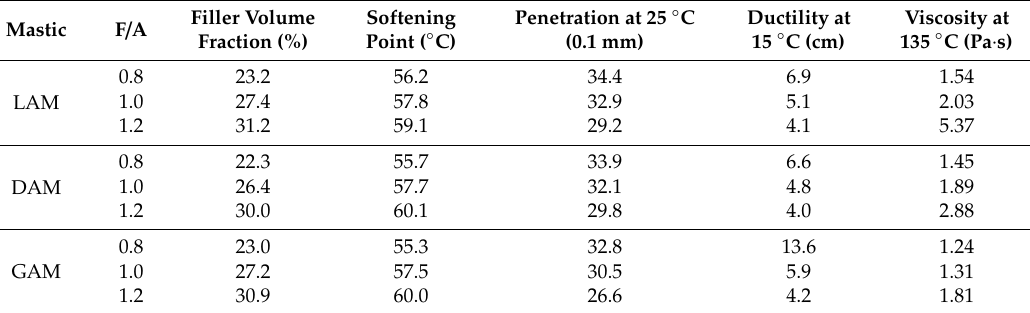
Table 3. Basic properties of asphalt